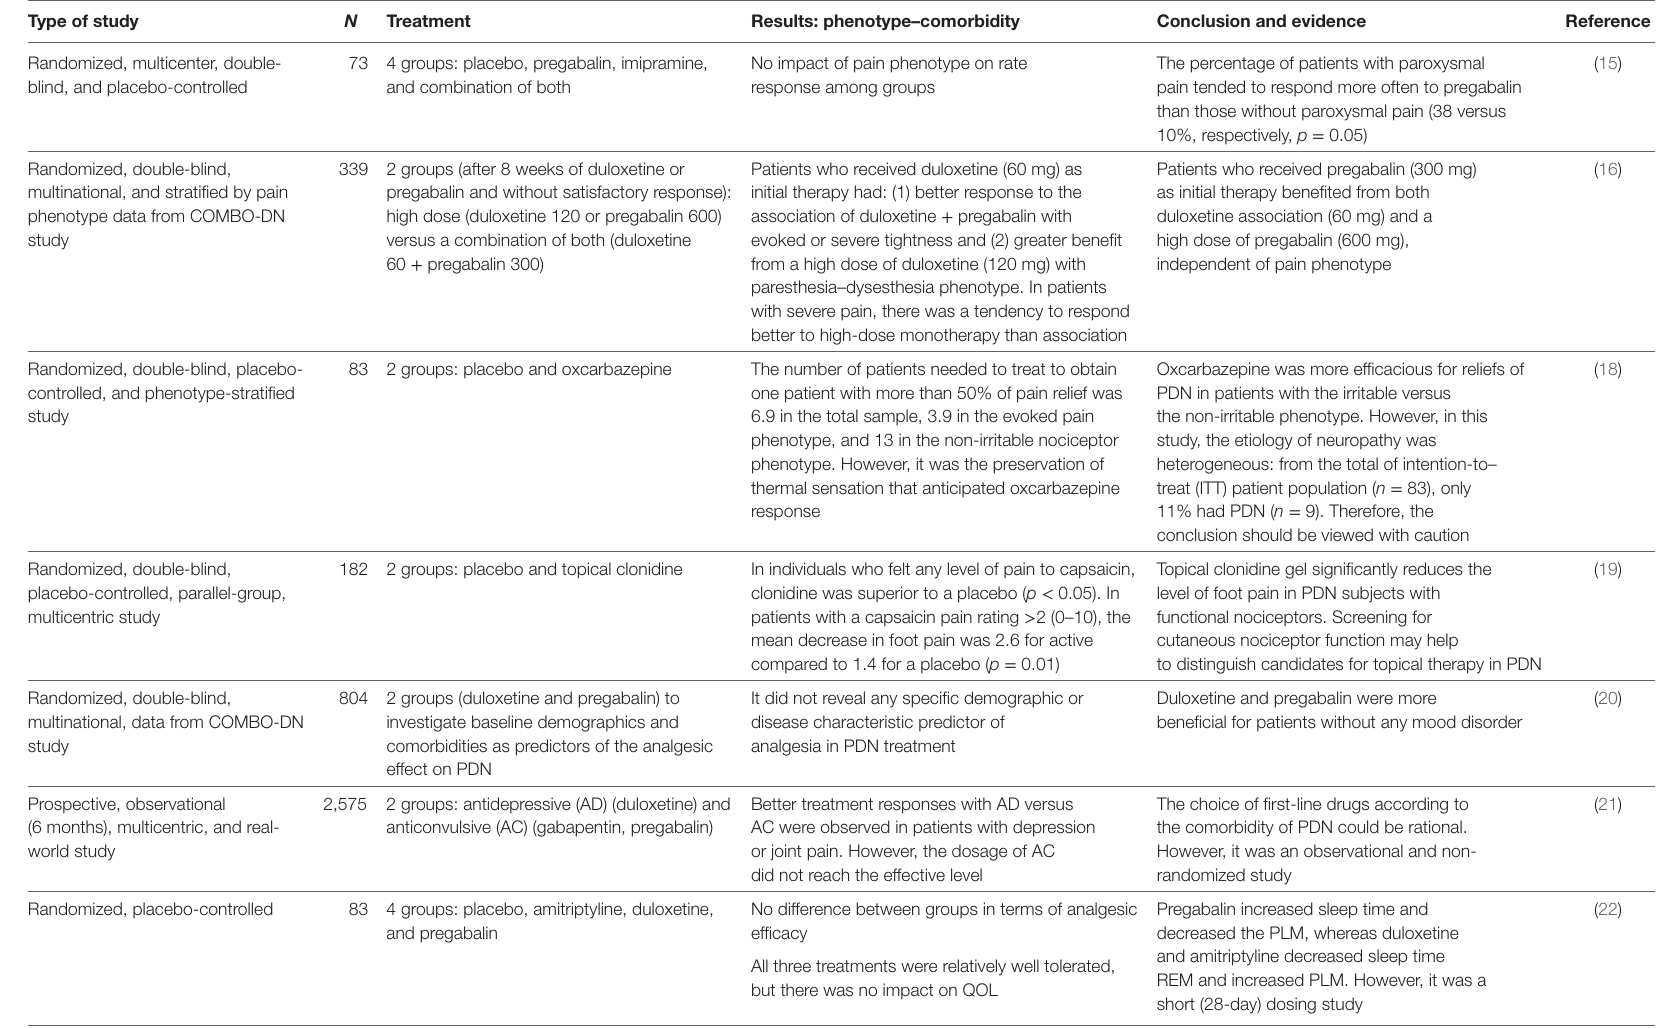
tABLe 1 | Summary of findings: the evidence for PDN treatment, based on pain phenotype and comorbidity. type of study N treatment results: phenotype–comorbidity conclusion and